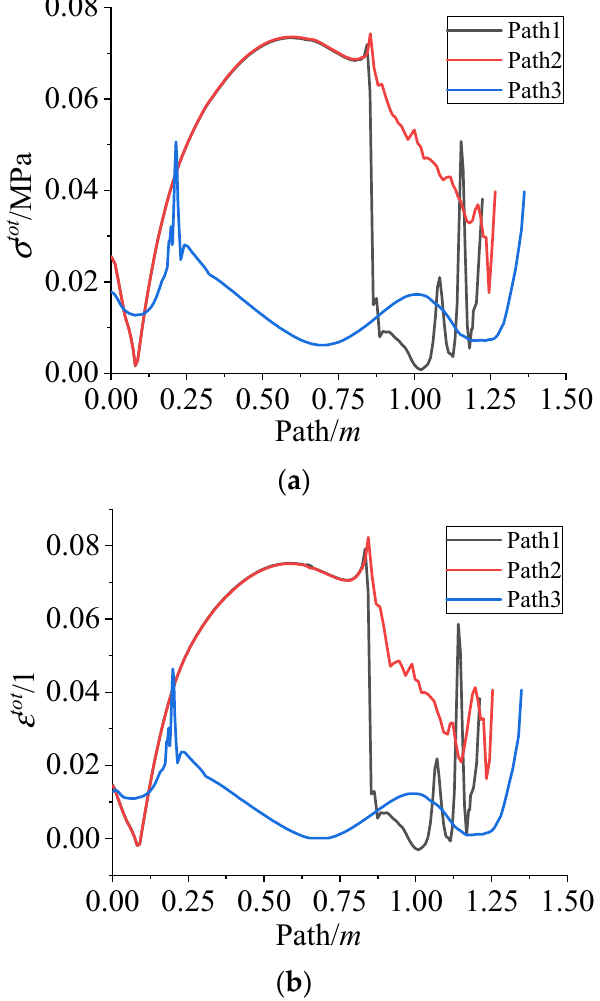
tot σ Figure 14. ( a ) The σ tot varies along path 1~3 during the cooling down process. ( b ) The ε tot varies Figure 14. ( a ) The varies along path 1~3 during the cooling down process. ( b ) The along path 1~3 during the cooling down along path 1~3 during the cooling down process.